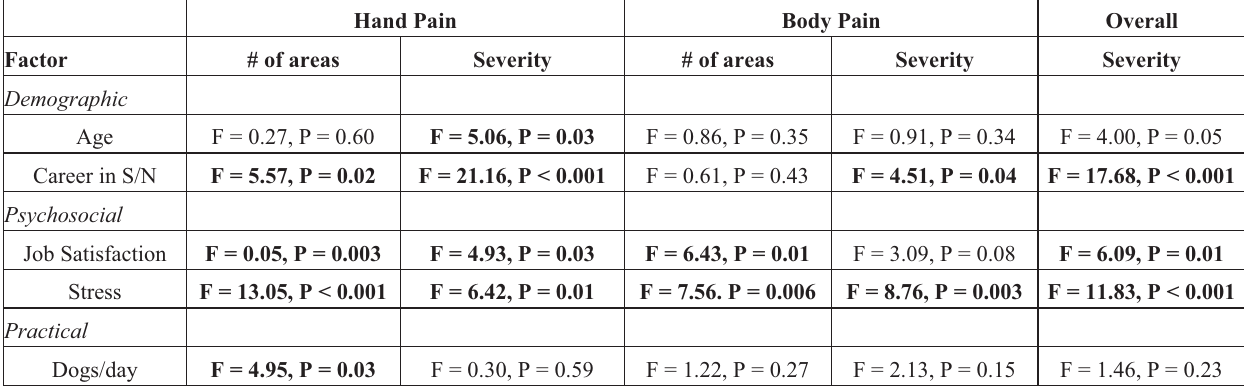
Table 1. Univariate linear regression results (all statistically significant relationships have positive